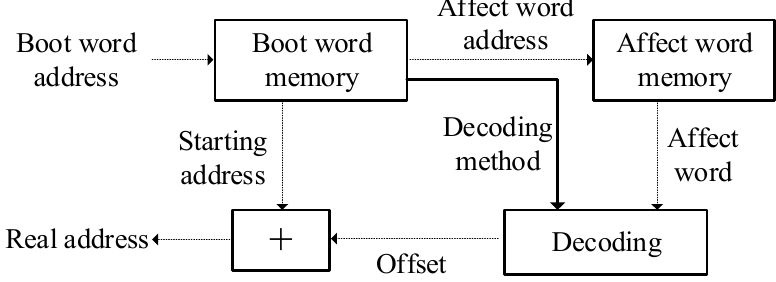
Figure 3. Indirect addressing workflow.